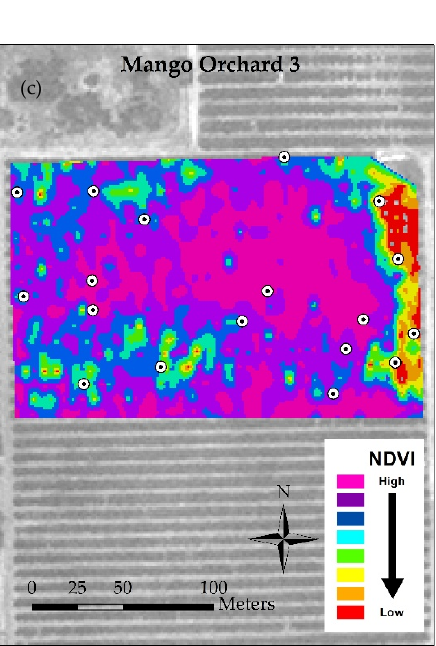
Figure 2. Classified Normalised Difference Vegetation Index (NDVI) images of the three mango orchards ( a ) Orchard 1 ( b ) Orchard 2 and ( c ) Orchard 3 with sampling locations for the 2016–2017 season presented as white circles.